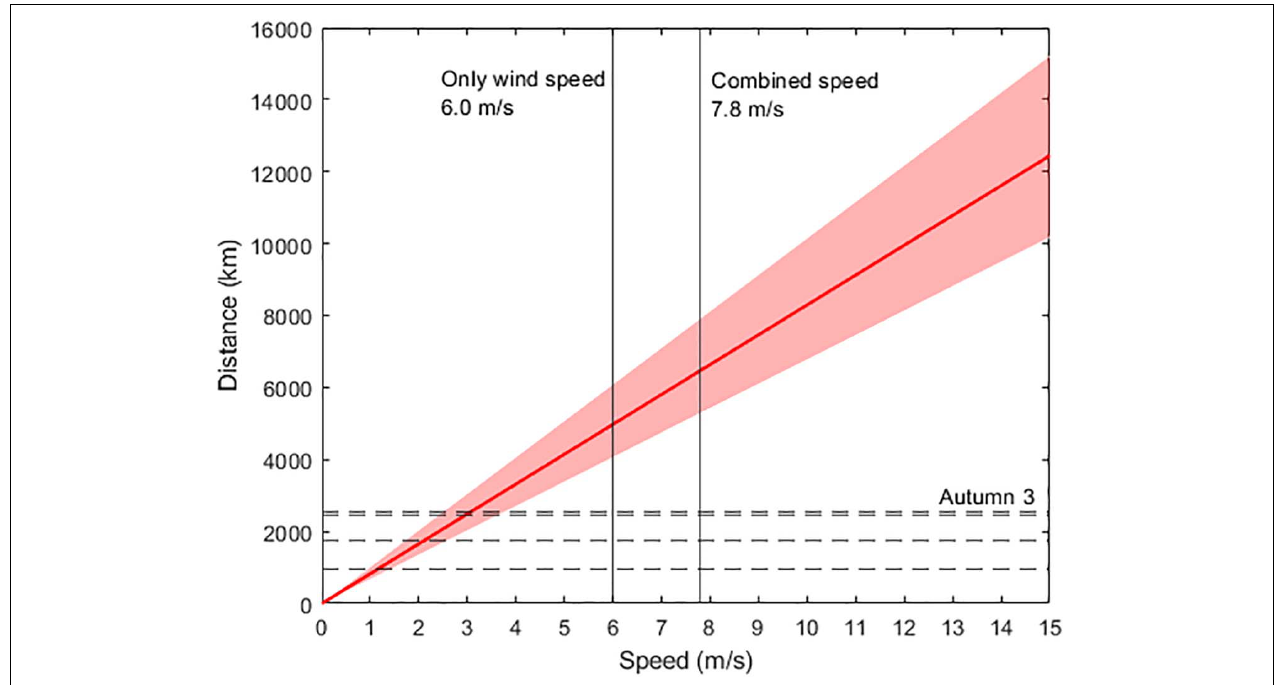
FIGURE 3 | Estimated flight distance assuming a combination of unaided flight and wind. The red line reflects a standard individual, and the shaded area reflects simulated variation of ± 10% in input variables (energy available and metabolic rate). The horizontal dashed lines denote various flight distances during the autumn and spring migration (Autumn 1: 938 km; Autumn 2: 1,744 km; Autumn 3: 2,536 km; and Spring 1: 2,430 km, see Table 2 ), with the longest migration labeled (Autumn 3: 2,536 km). The vertical, solid lines denote mean wind speed during the autumn migration based on wind trajectory analyses (6 m/s), and mean wind speed during the autumn migration with the addition of the mean unaided flight speed (1.8 + 6 = 7.8 m/s).